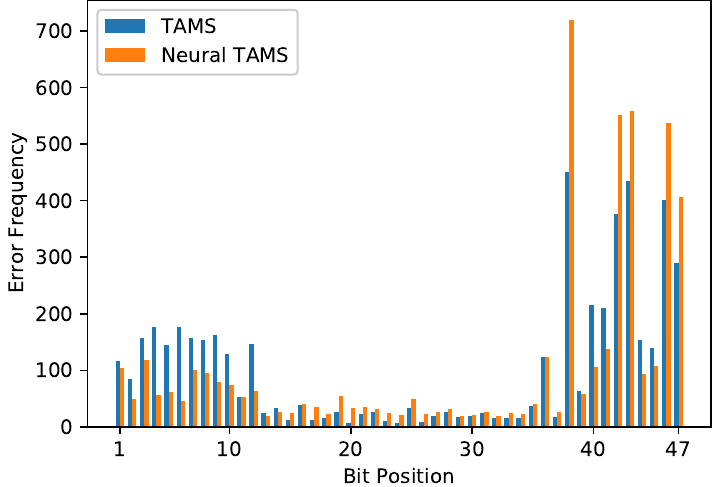
Figure 7. Error distribution comparison between TAMS and Neural TAMS for the (47,24) QR code. All decoders applied 5 min-sum